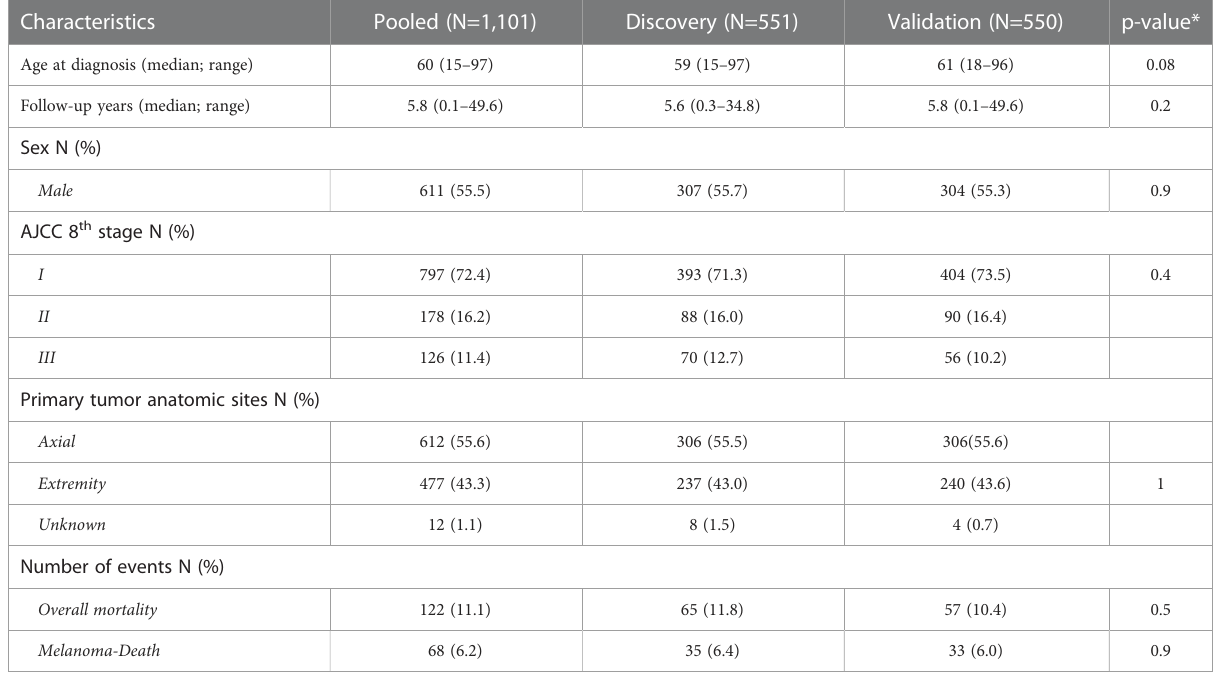
TABLE 1 The clinical and demographic information for the patient population in the discovery, validation and pooled cohort .